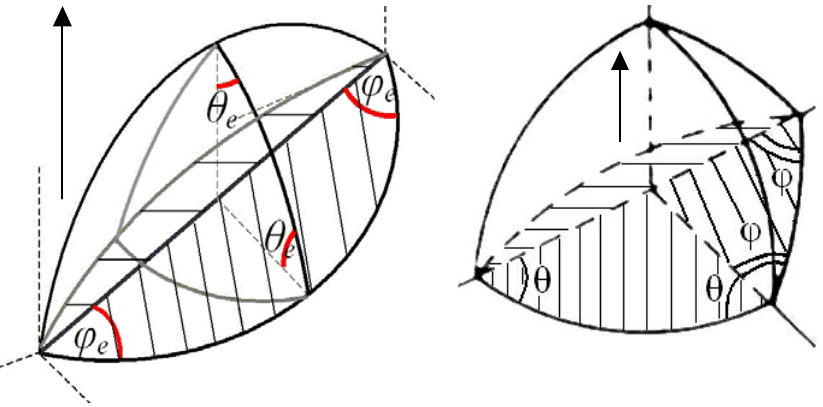
Figure 5. Peripheral grain boundary bubbles (edge and